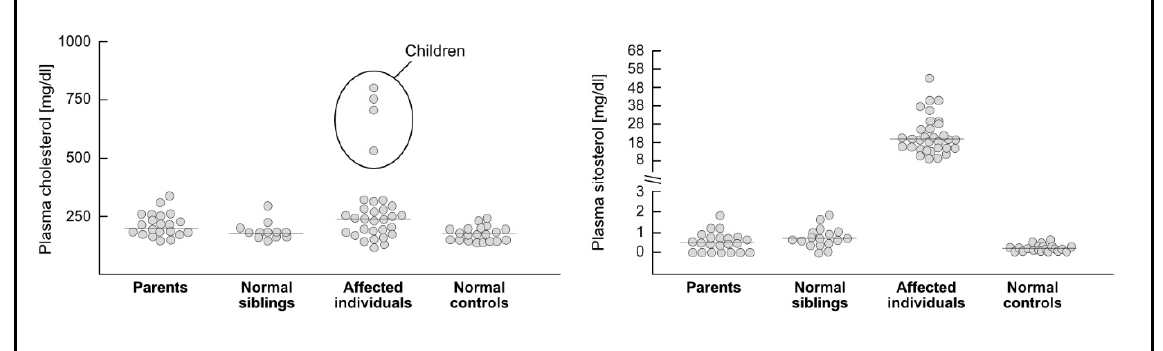
Figure 2. Plasma concentrations of total cholesterol and sitosterol in heterozygous (parents) and homozygous phytosterolemia cases versus unaffected siblings and unrelated controls (according to